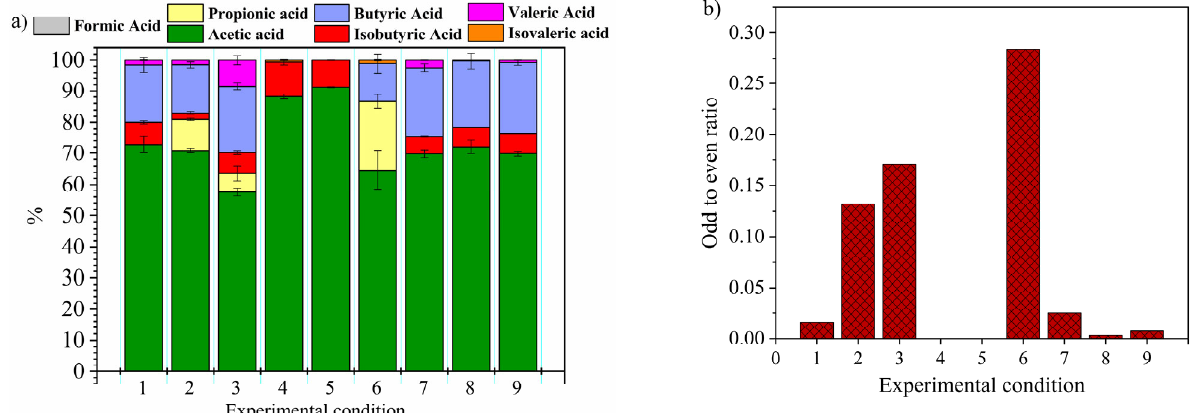
Figure 3. ( a ) Profile of VFAs obtained in each experimental condition of the Doehlert experimental design; ( b ) Odd-to-even ratio and acidification efficiency obtained in each experimental condition of the Doehlert experimental design.